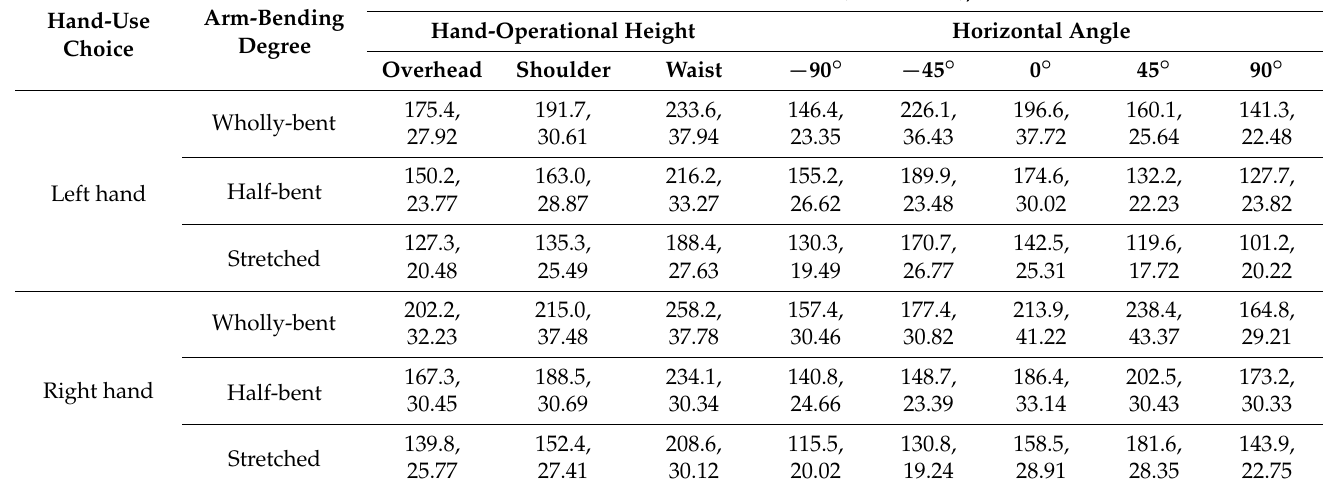
Table 5. Hand durations (in seconds) in different conditions of hand-use choice, hand-operational position and arm-bending